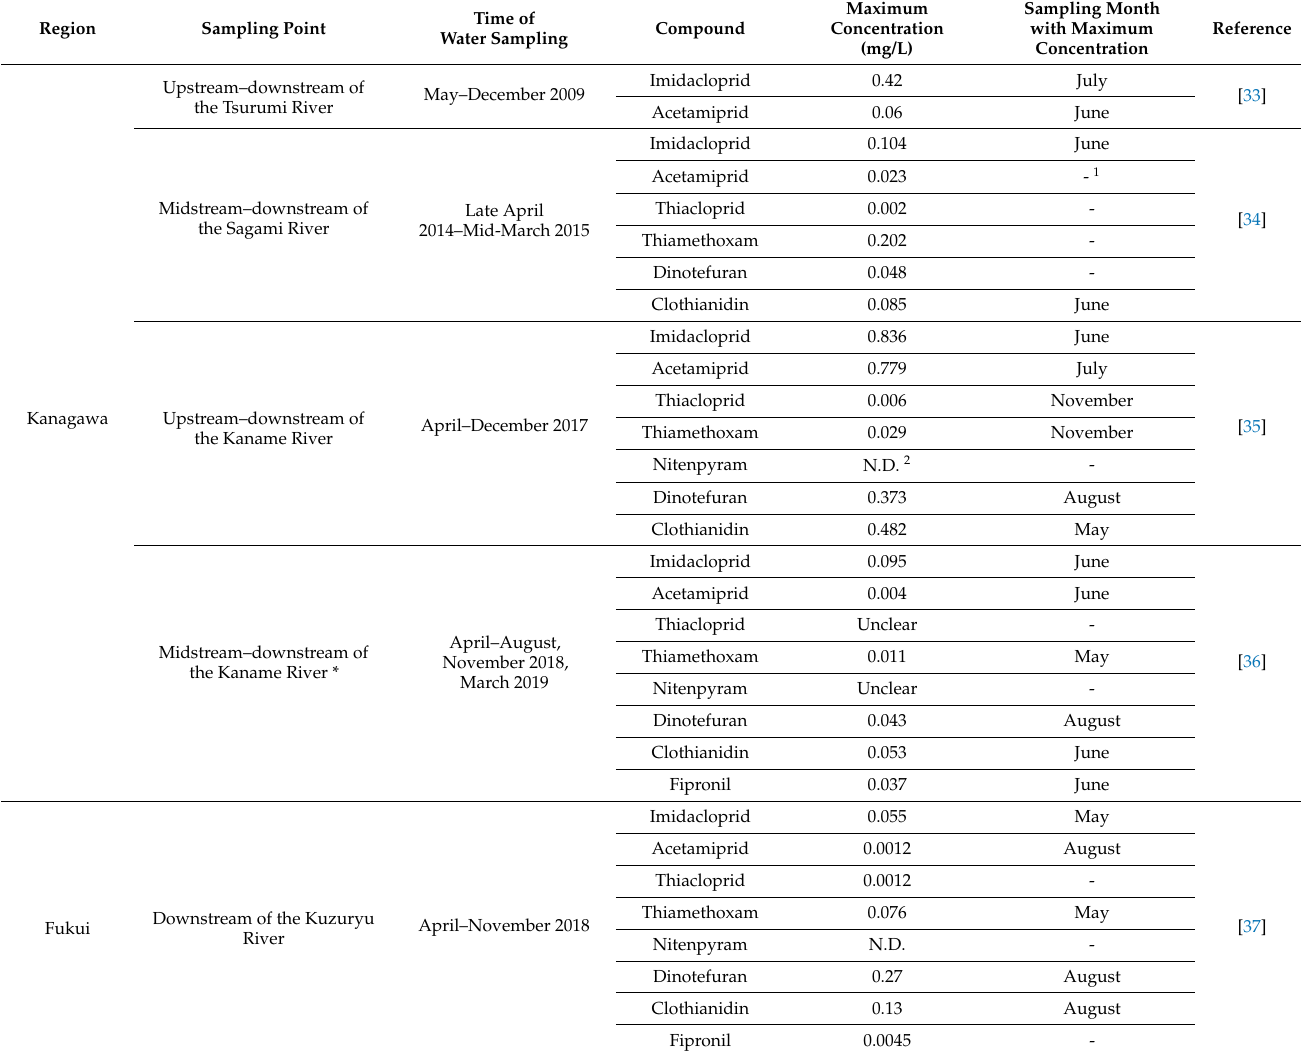
Table 1. Maximum concentrations and sampling months of neonicotinoid pesticides in Japanese rivers, as reported in previous